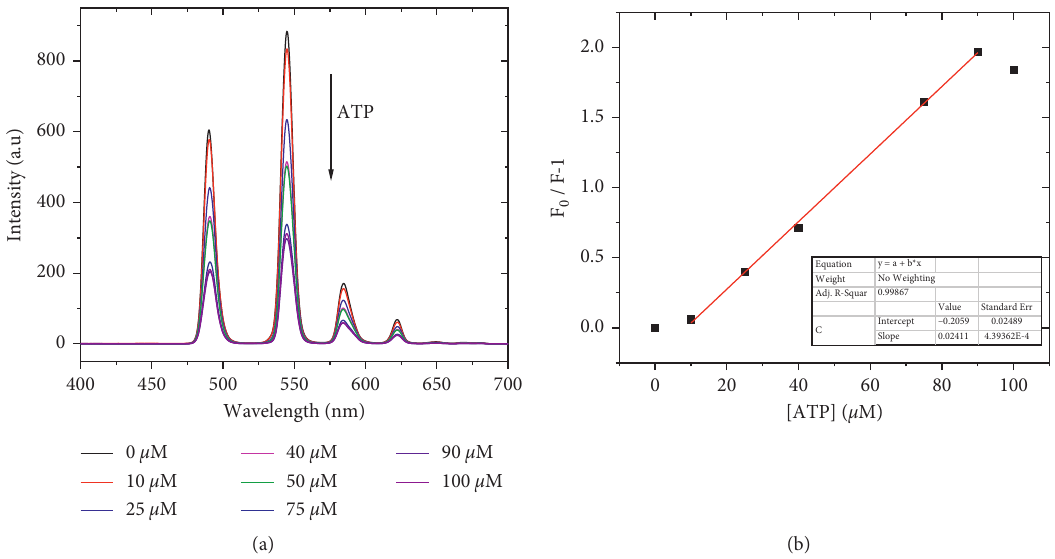
Figure 4: (a) Fluorescence spectra of 1 at various concentrations of ATP in Tris-HCl buffer solution (pH 7.4). (b) Stern–Volmer plot corresponding to the obtained data in (a).